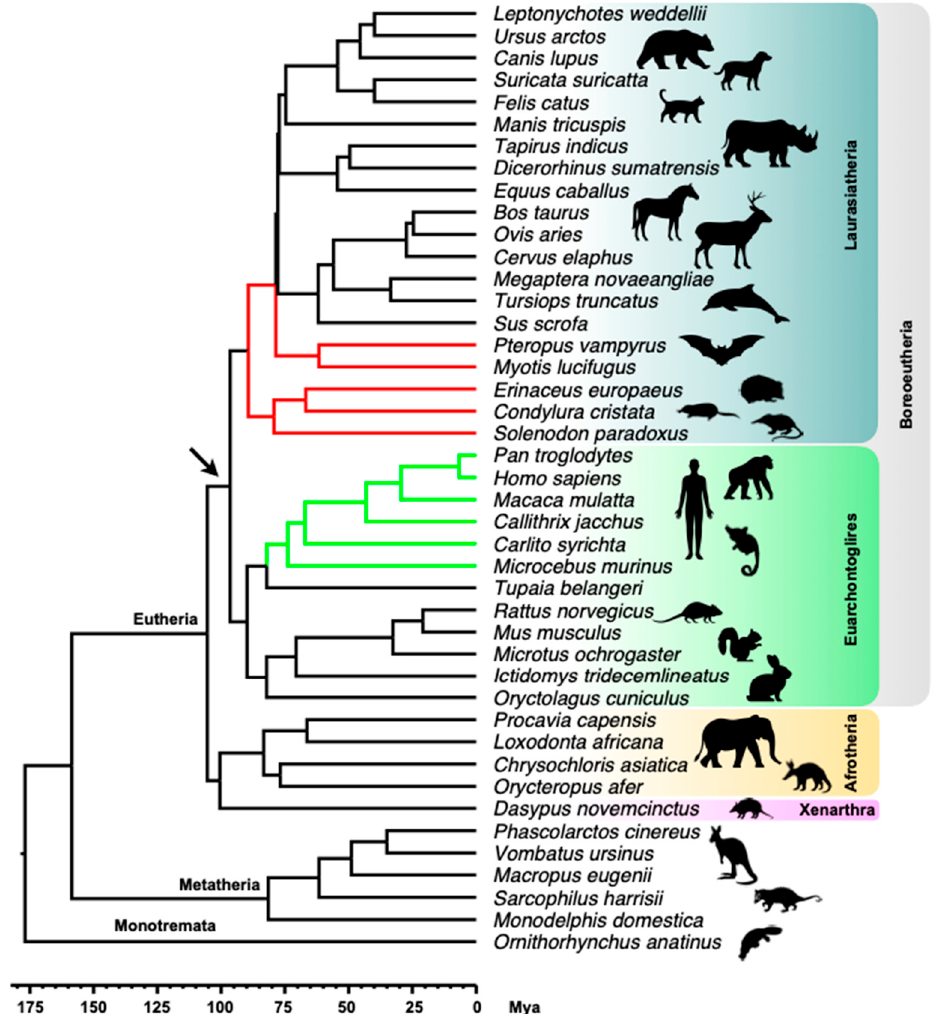
Figure 5. Schematic drawing of mammalian time tree, showing the MER6 elements distribution. Green branches correspond to MER6 and MER6A distribution, coincident with primates. Red branches indicate lineages were only MER6A has been retrieved (bats and eulipotyphlans lineages). The arrow marks where MER6 elements putatively originated. High-level taxonomy is reported on the right of the tree.